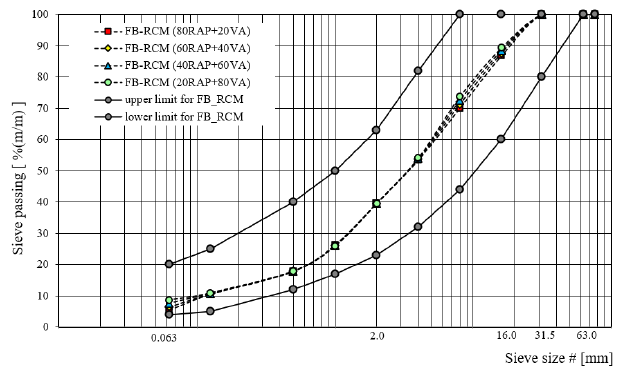
Figure 3. Gradation curve for FB-RCM with RAP.